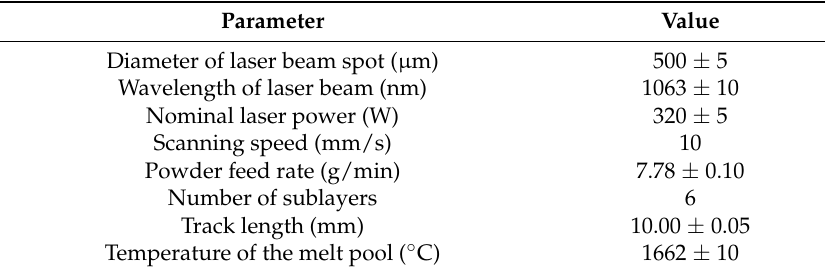
Table 1. Laser metal deposition process